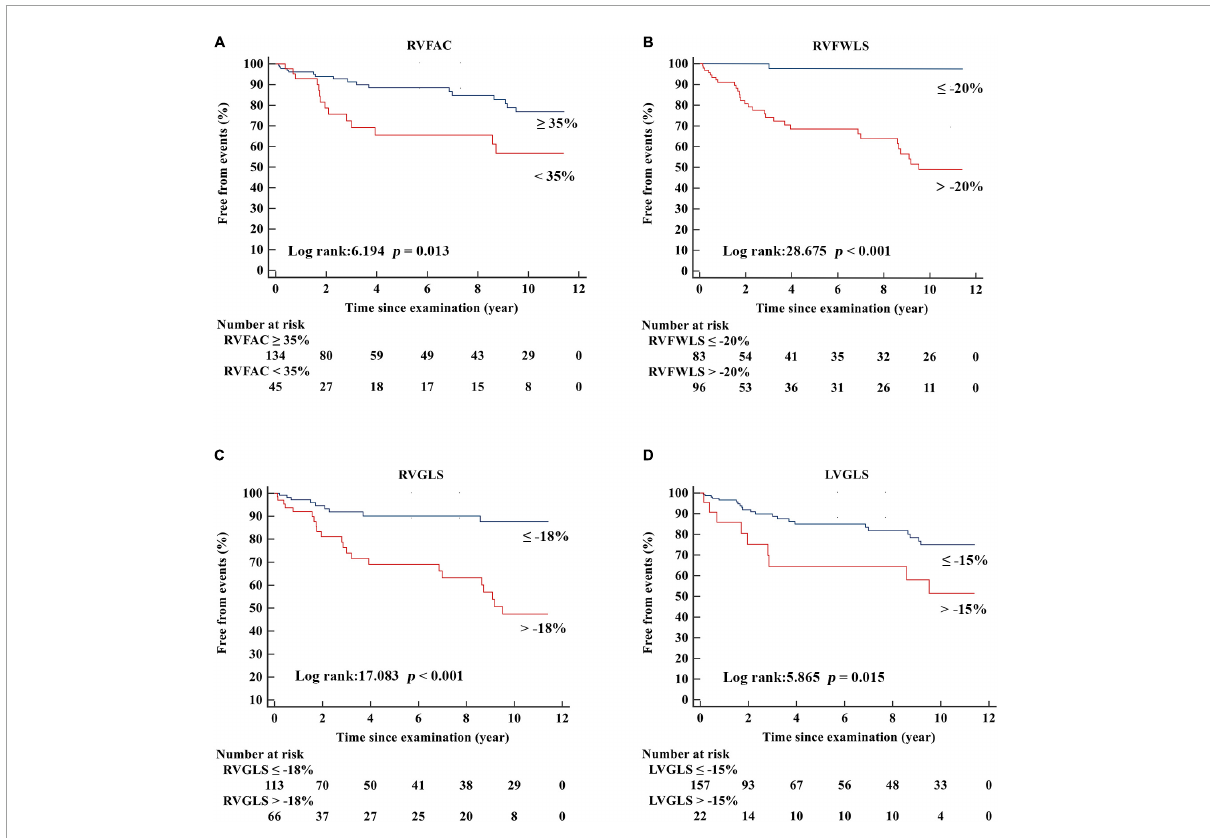
FIGURE3 Kaplan–Meier freedom from events curves according to (A) RVFAC, (B) RVFWLS, (C) RVGLS, (D) LVGLS in patients with r-TOF.